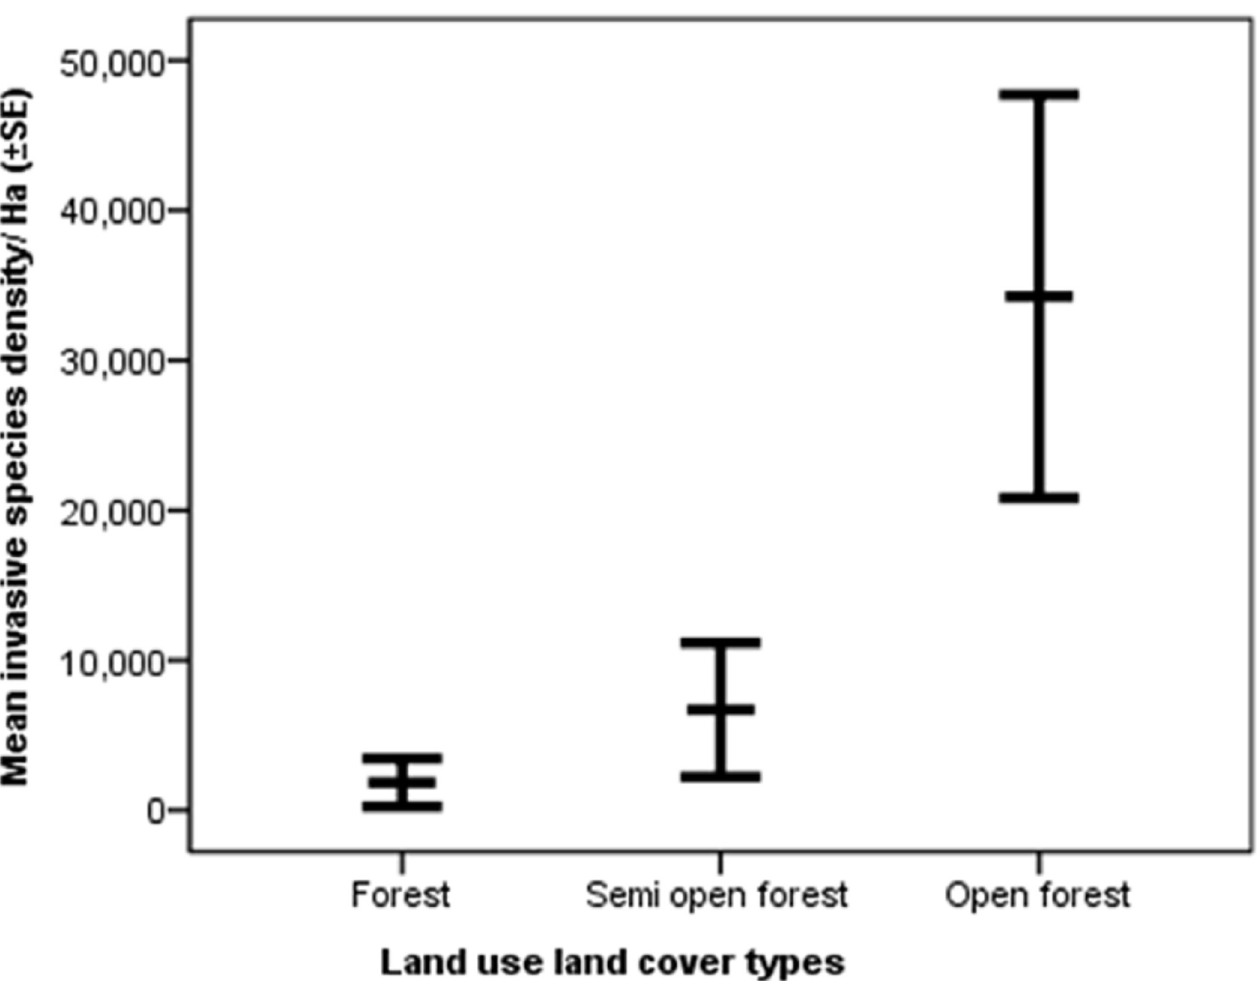
Fig 8. Mean ( ± SE) invasive species density in the forest, semi-open forest, and open forest.